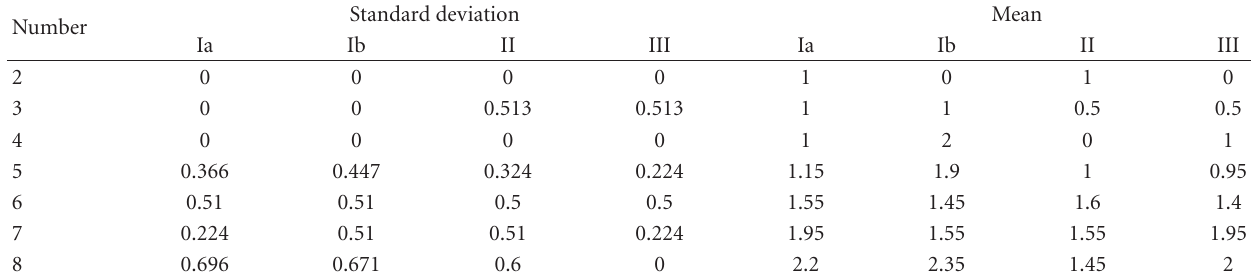
Table 2: Distribution of the four classes from Figure 1 for di ff erent number of clusters, N = 2 to 8, for 20 di ff erent runs. Represented are in function of the number of clusters the mean and standard deviation of the clusters to the four Kuhl classes Ia, Ib, II, and III.